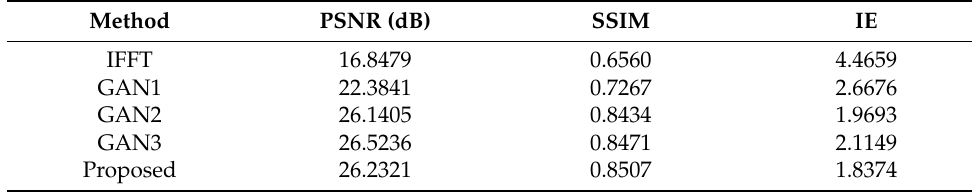
Table 3. Numerical performance evaluation for simulated aircraft at SNR = 2